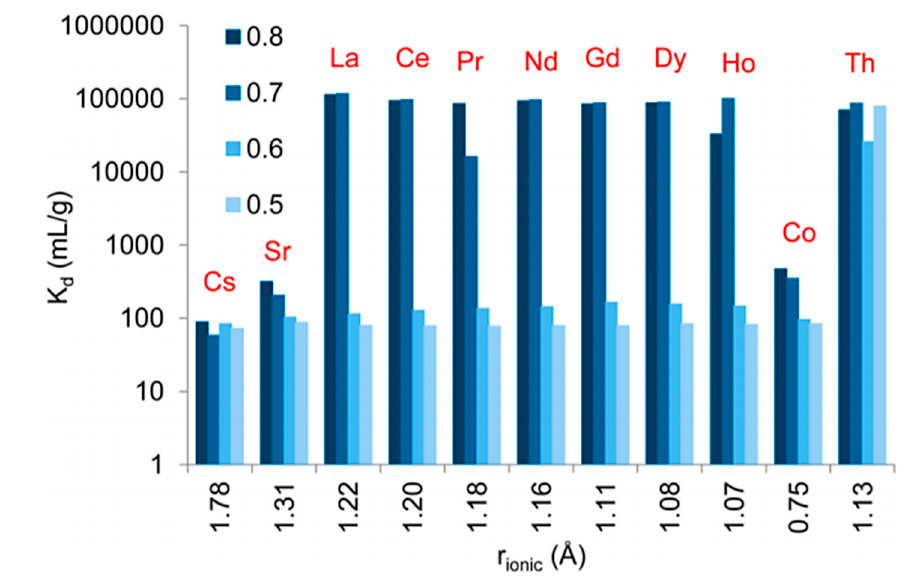
Figure 8. Extraction of cations of different ionic radius by poorly crystalline ZrBTP-0.8, ZrBTP-0.7, ZrBTP-0.6, ZrBTP-0.5, prepared in the absence of HF from mixed cation solutions with each cation at nominal 20 mg/L in 0.10 M HNO 3 . Reprinted with permission from [108]. Copyright (2016), American Chemical Society.